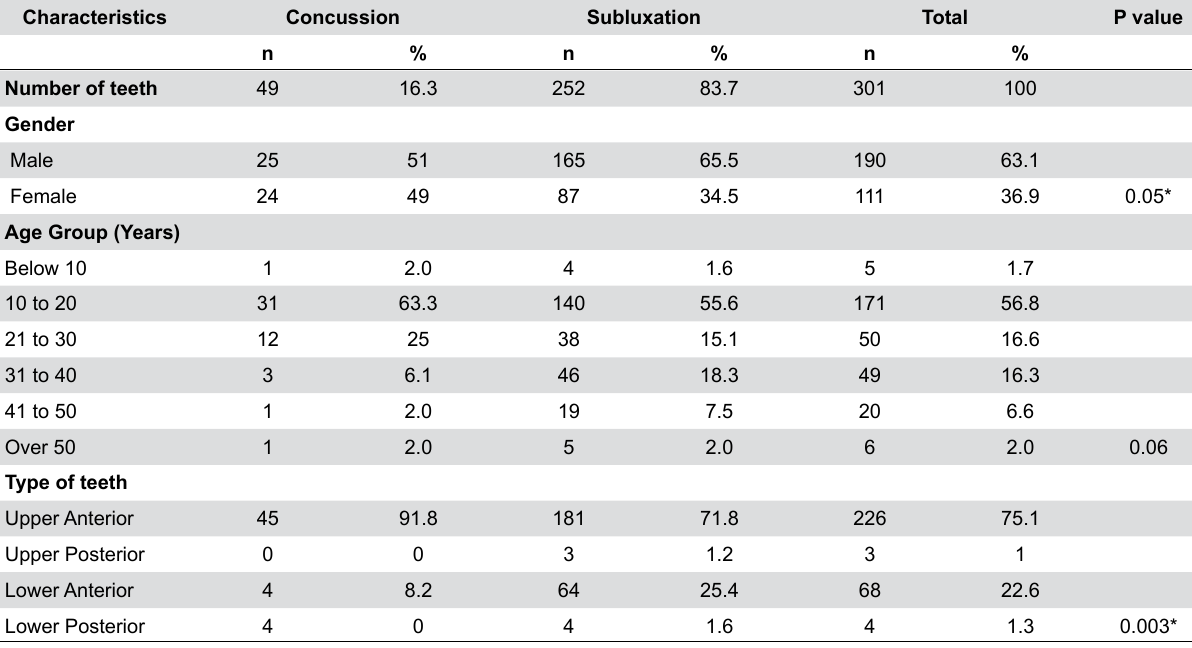
Table 1- Demographic characteristics and type of teeth in the cases of concussion and subluxation